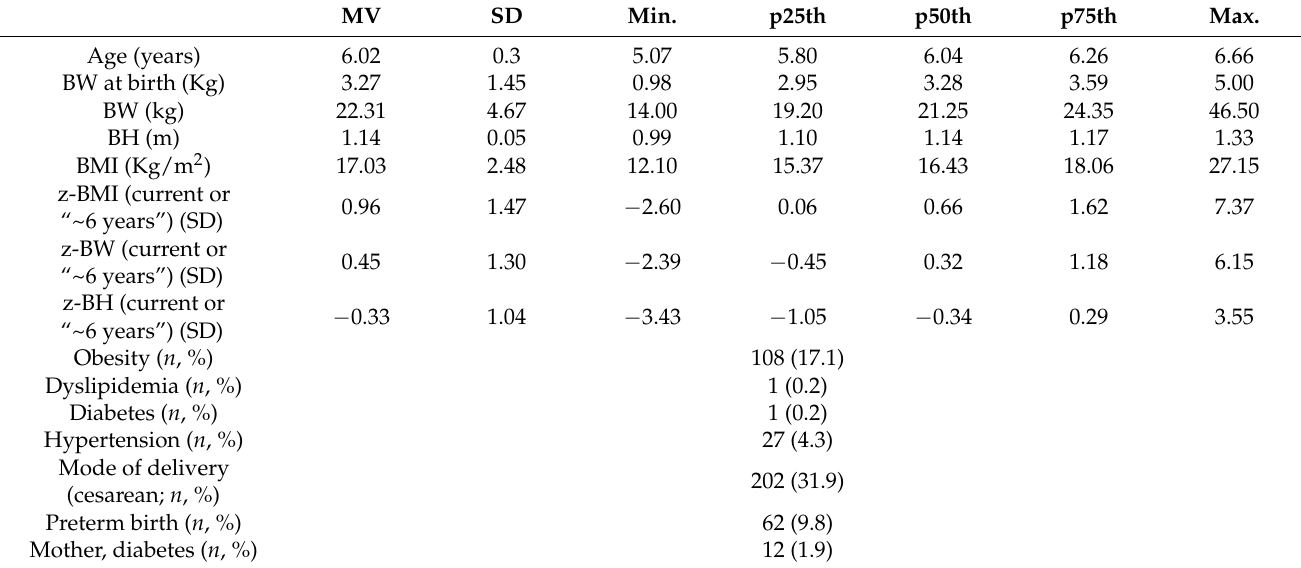
Table 1. Children ´ s characteristics at age 6 years ( n = 632; female: